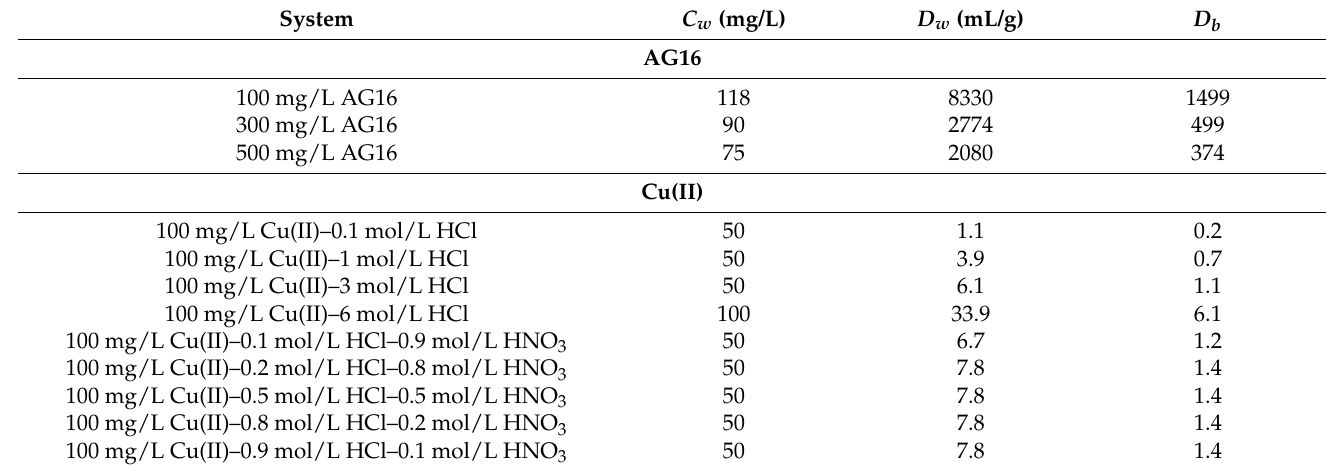
Table 4. Column parameters calculated for AG16 and Cu(II) sorption on S5528.